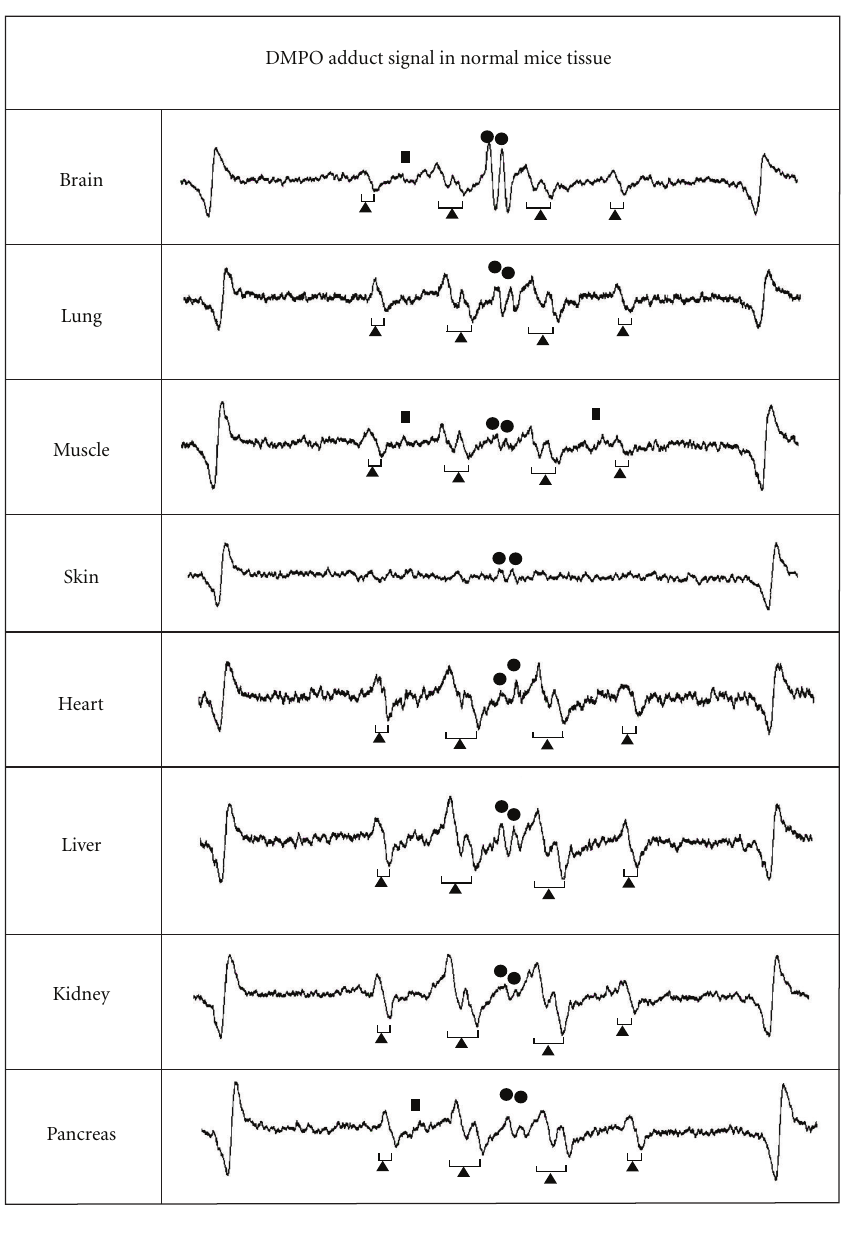
Figure 2: The representative examples of DMPO adduct signals from various mice tissues. The marks ( • , (cid:2) , and (cid:3) ) show the peaks that were the same peaks having the g -value of standard